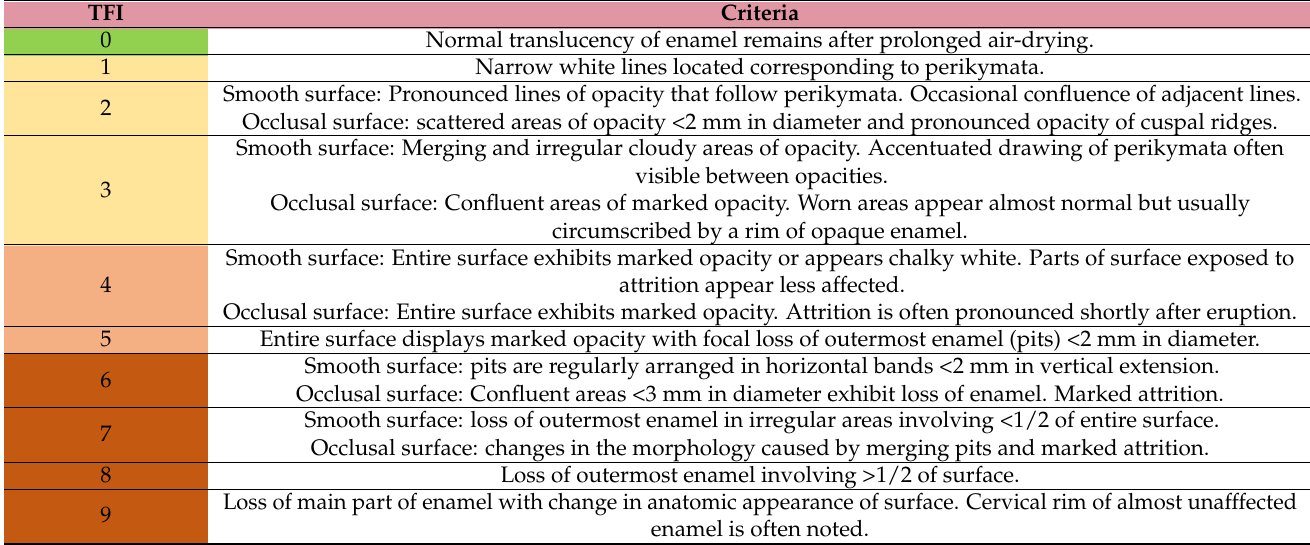
Table 1. Thylstrup and Fejerskov index (Fejerskov et al., 1988): mild (1–3), moderate (4–5), and severe (6–9). TFI Criteria 0 Normal translucency of enamel remains after prolonged air-drying. Narrow white lines located corresponding to perikymata. Smooth surface: Pronounced lines of opacity that follow perikymata. Occasional confluence of adjacent lines.